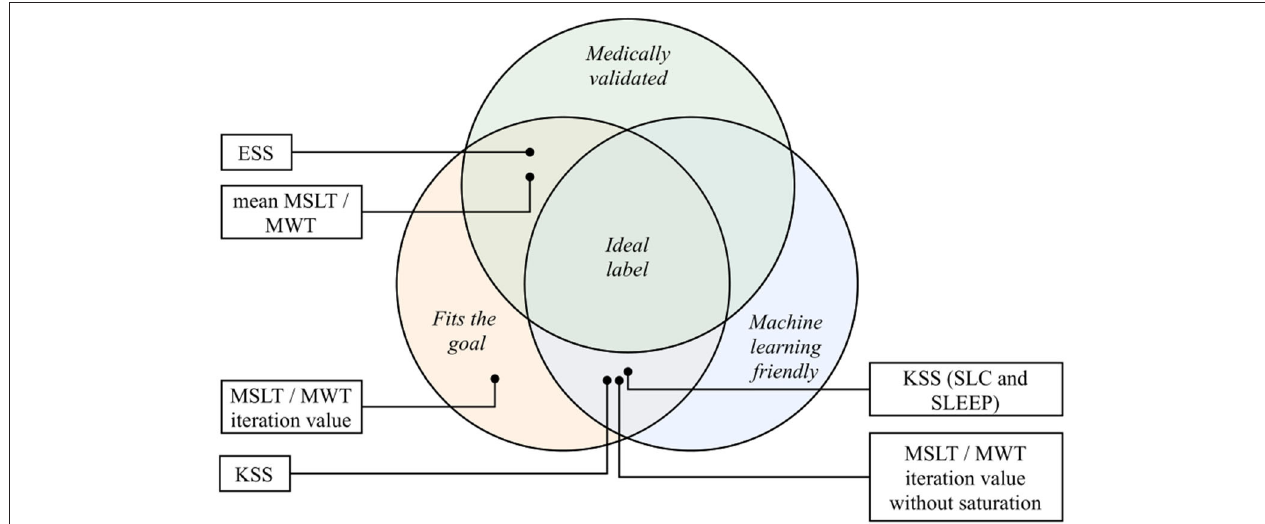
FIGURE 9 | The different sleepiness measures of this study place on the three axes of the ideal label: medical validation, machine learning fitting and goal fitting. KSS, Karolinska Sleepiness Scale; ESS, Epworth Sleepiness Scale; MSLT, Multiple Sleep Latency Test; MWT, Maintenance of Wakefulness Test.